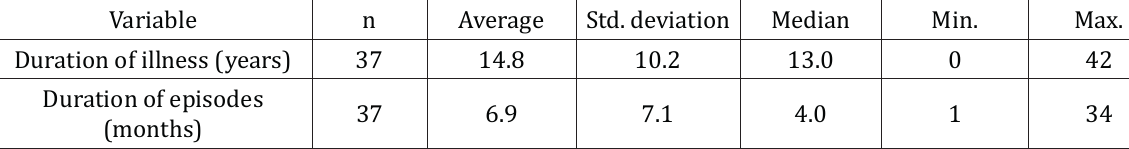
68 Table 2. Descriptive statistics – duration of sickness and episodes among the tested patients